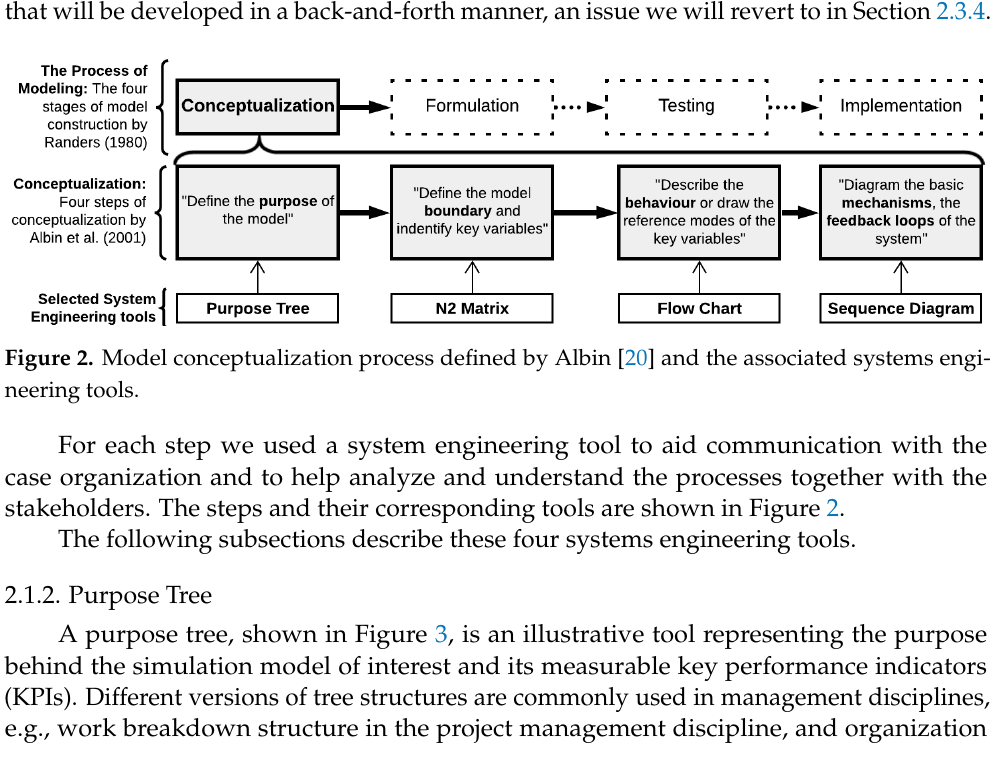
Figure 1. Randers’ modeling methodology.